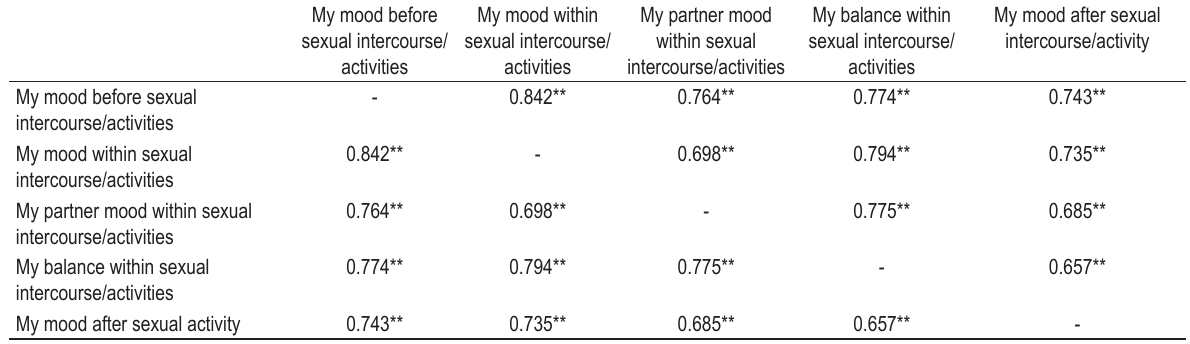
TABLE 4. Person’s correlations between